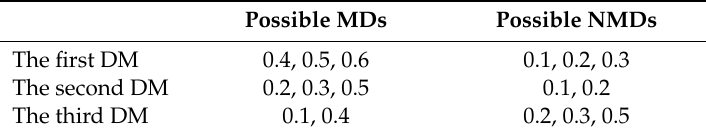
Table 1. The evaluation information provided by DMs in Example